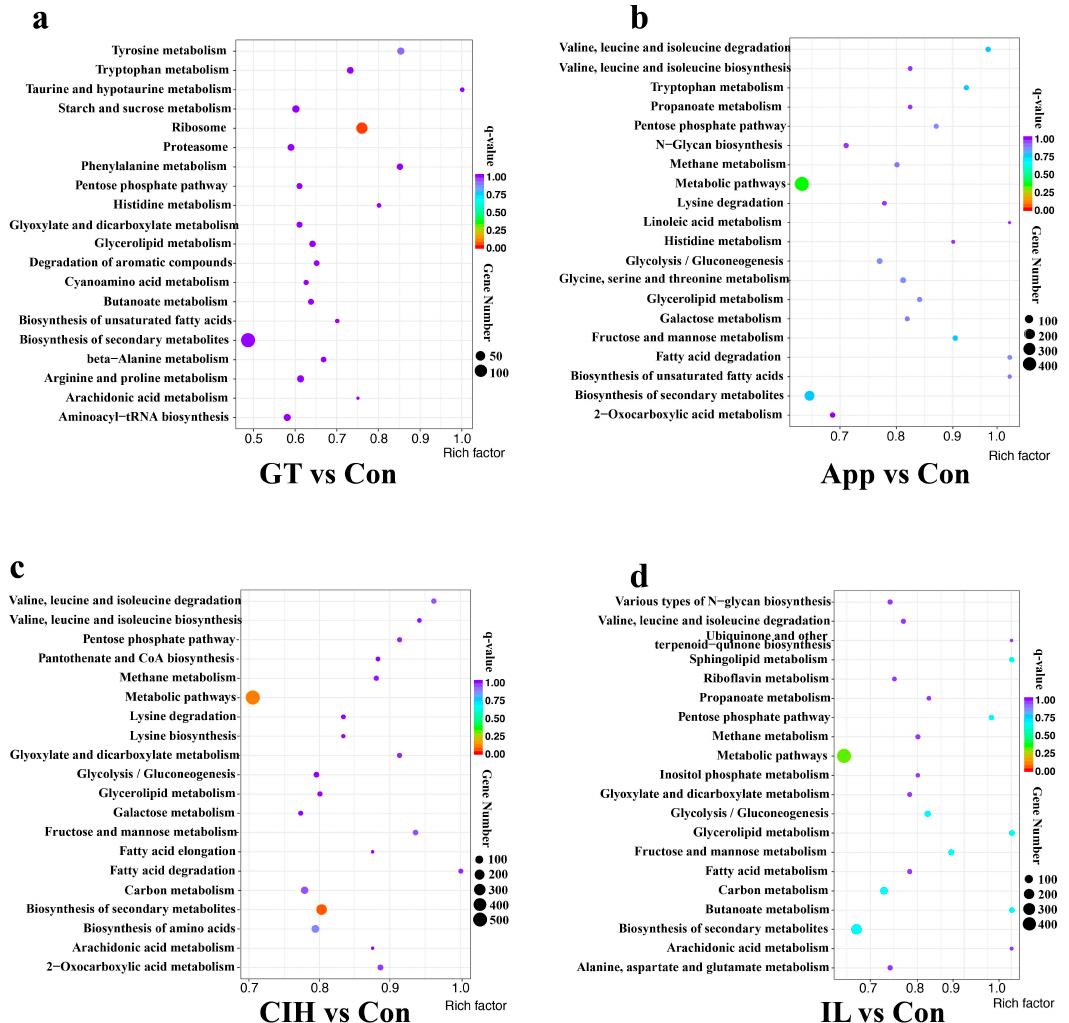
functional classification of all DEGs; red column means the number of up-regulated DEGs, blue column means the down-regulated DEGs. ( b ) TopGO analysis of key GO terms in di ff erent growth stages of C. camelliae ; the color represents the degree of enrichment: the brighter the color, the higher the degree of enrichment. (Con: conidium; GT: germ tube; App: appressoria; CIH: cellophane infectious hyphae; IL: infection leaves; BP: biological process; CC: cellular component; MF: molecular function).